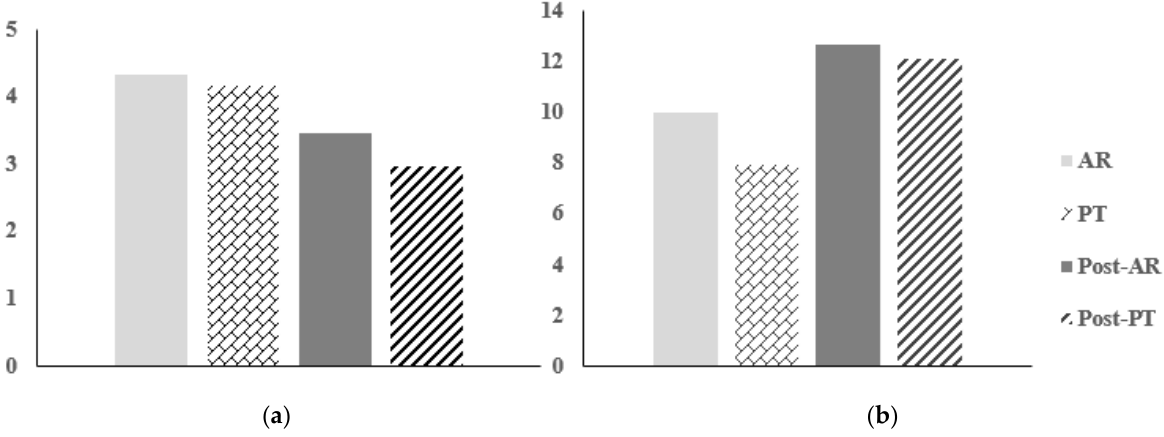
Figure 7. Comparison of positioning sensation and flexibility between groups after intervention ap- plication: ( a ) Positing sensation; ( b ) Flexibility. application: ( a ) Positing sensation; ( b ) Flexibility. Table 8. Comparison of positioning sensation within and between groups before and after interven- tion